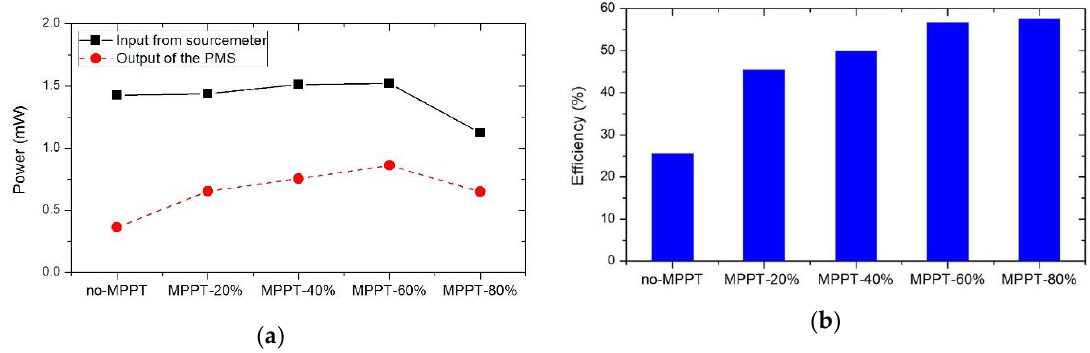
Figure 6. Performance characteristics of developed PMS: ( a ) Input power from the source meter and output power of the PMS as functions of voltage ratio; ( b ) Conversion efficiencies of the PMS in different voltage-ratio configurations.